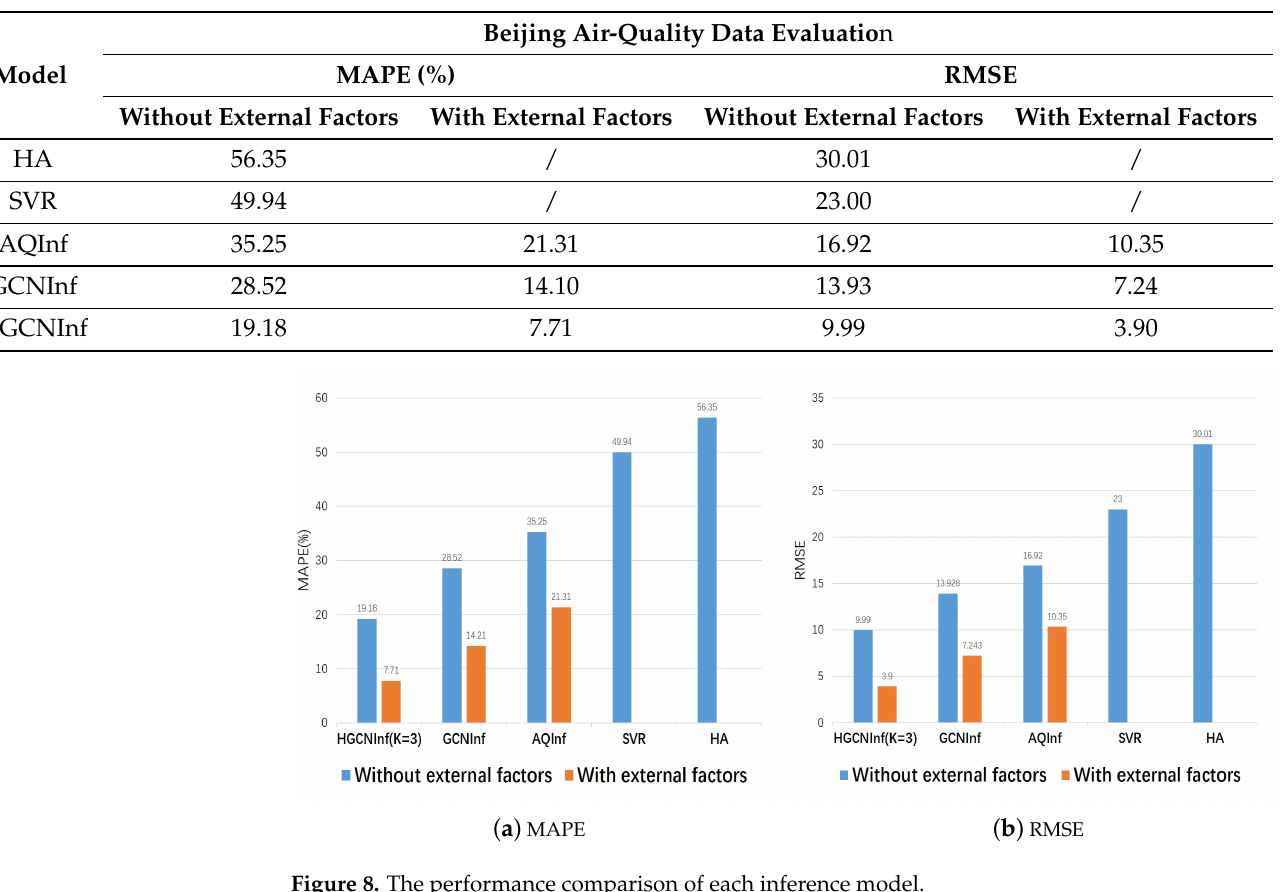
Table 2. The performance comparison of inference models.